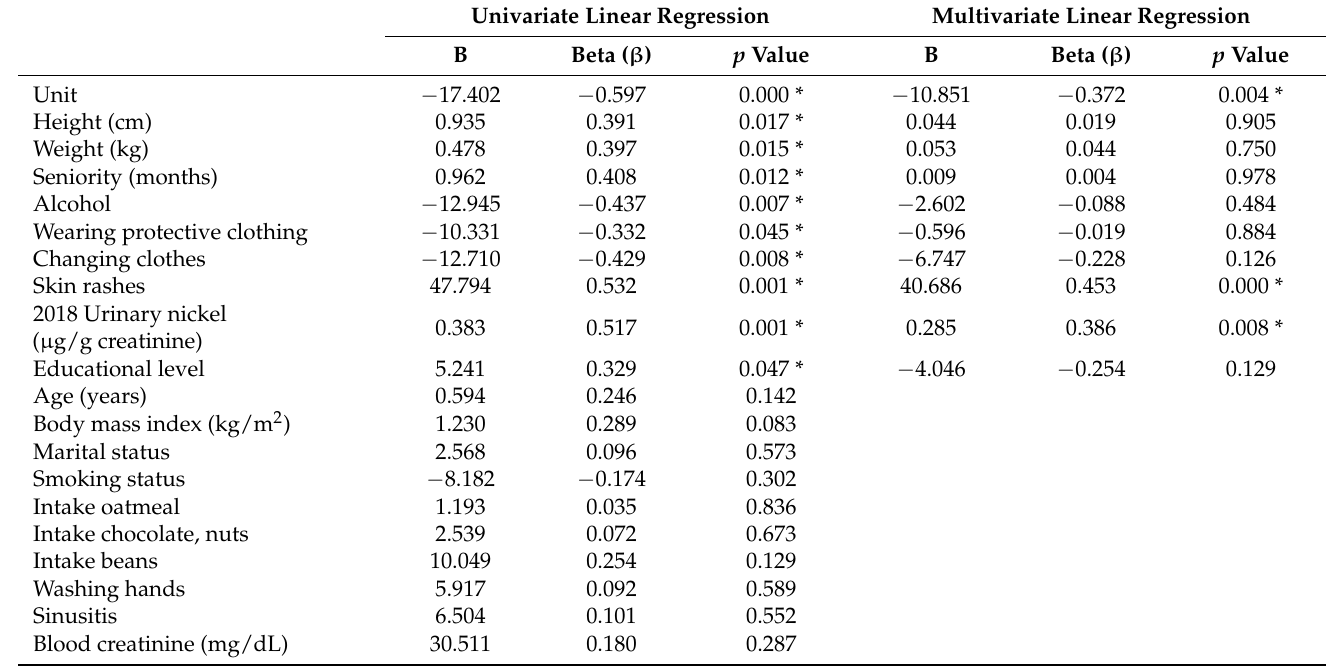
Table 3. Relationships between post-intervention urinary nickel levels and demographic and clini- cal